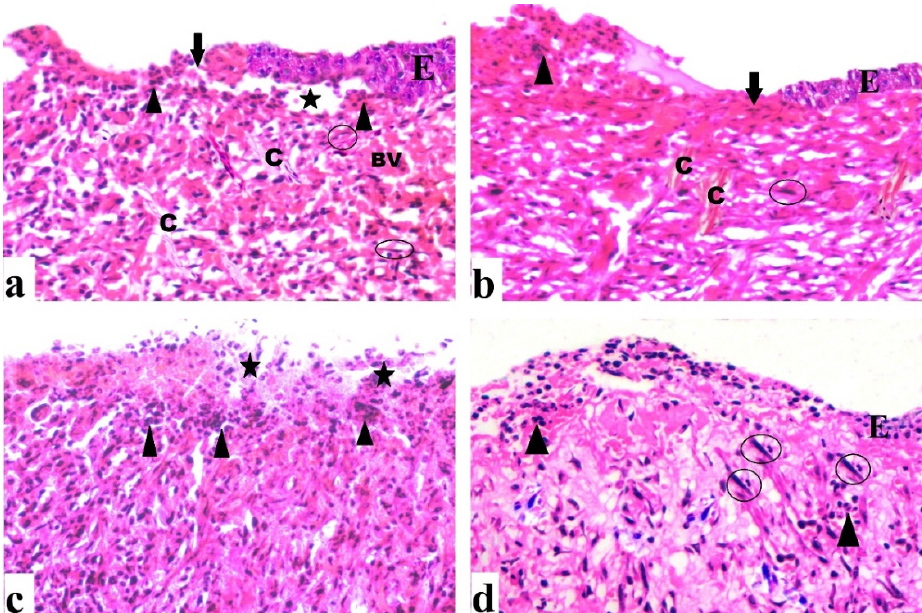
Figure 7. Sections were taken from a skin wound on day 7. ( a ) An untreated wound demonstrated epidermal loss (arrow), as well as dermal and epidermal separation (star). Inflammatory cells (arrowhead) are apparent, as are several fibroblast cells (circle), as well as congested blood vessels (BV) and regular collagen fibers (C). ( b ) A wound treated with DEEL showed epidermal loss (arrow), epidermal layer regeneration (E) with inflammatory cells (arrowhead), collagen fibers (C), and several fibroblast cells (circle). ( c ) An MRSA-infected wound displayed extensive inflammatory cells (arrowhead) as well as necrotic tissue (star). ( d ) MRSA-infected wound + DEEL treatment showed wound re-epithelialization (E) with significant inflammatory cells (arrowhead), aggregation, and fibroblast proliferation (circle) (H&E X200).